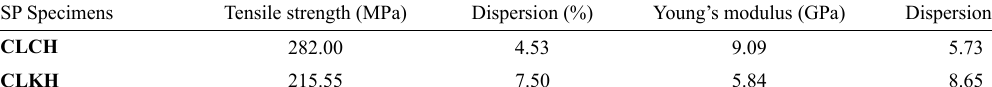
Figure 3. Stress x Strain curves. (a) CLKH specimens. (b) CLCH specimens. Table 3. Tensile strength and Young’s modulus. Central hole condition.